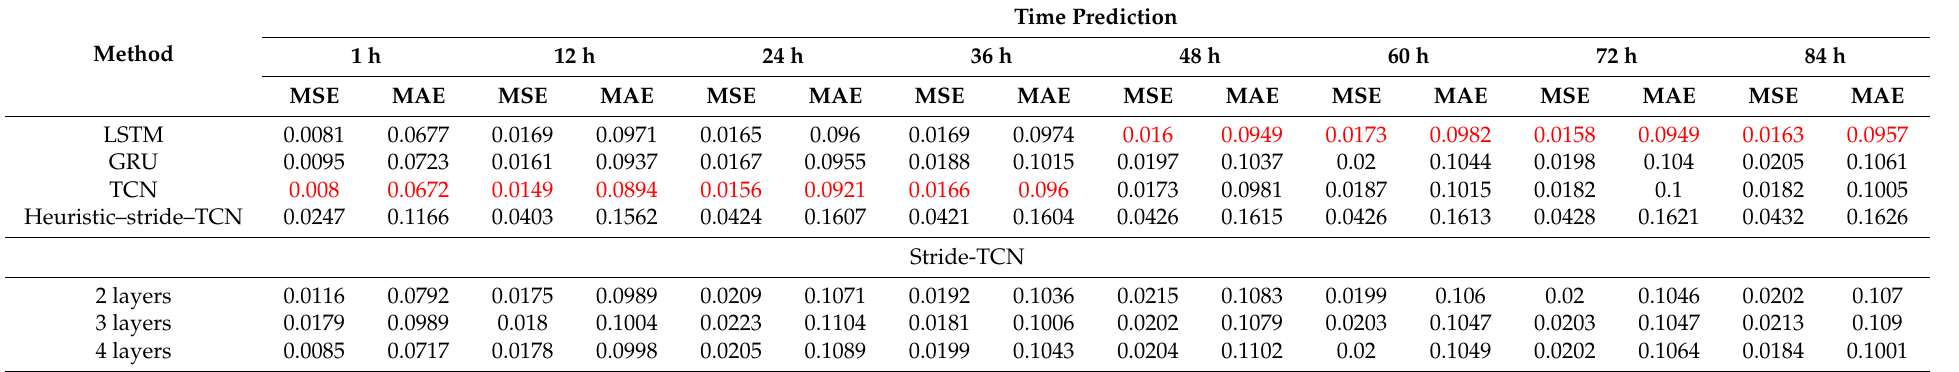
Table 6. Performance (MSE and MAE) of all models on the Spain